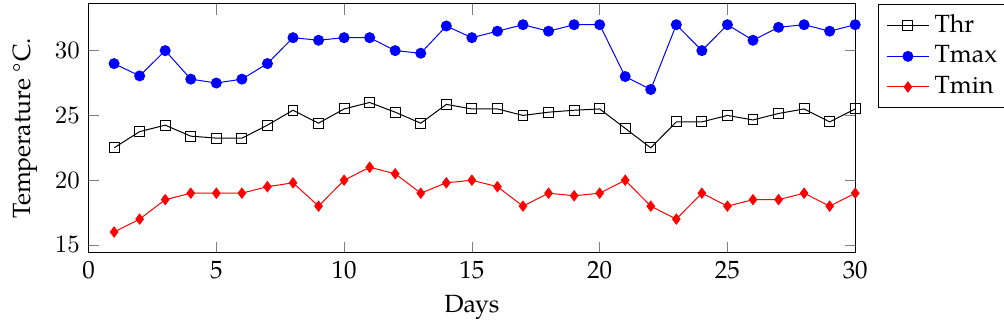
Figure 8: Experimental temperature